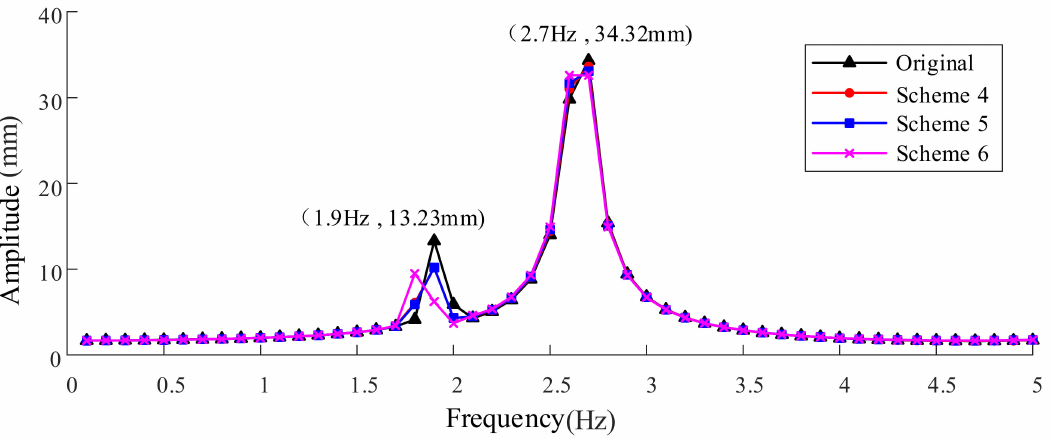
Figure 10. The vibration amplitude of the original large headframe and the improved headframe under the schemes 4, 5, and 6.